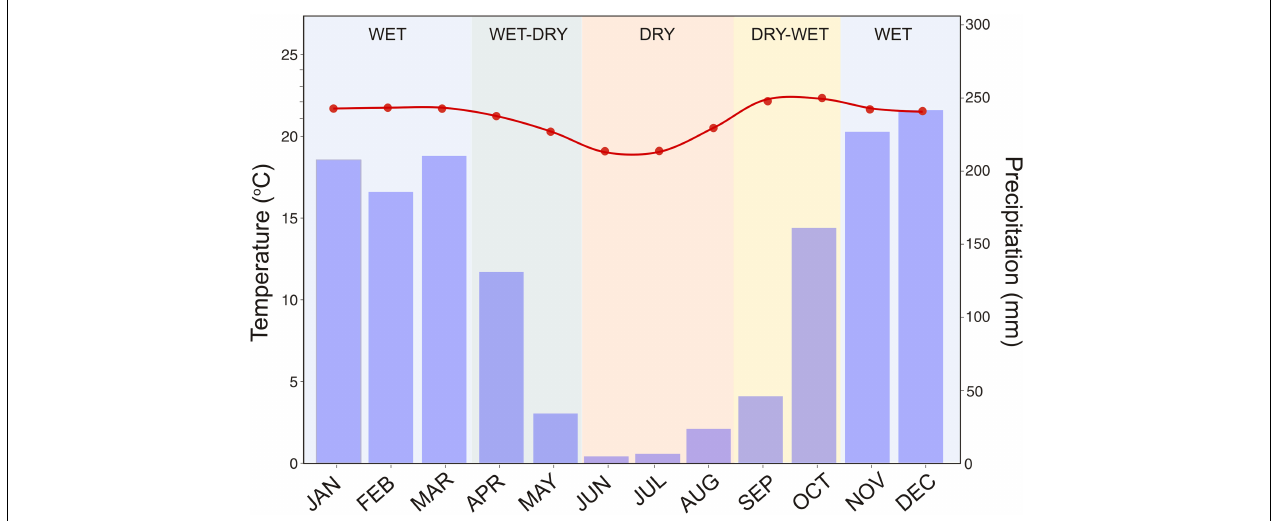
FIGURE 1 | Climatogram of the Brazilian Cerrado using records of precipitation (bars) and temperature (red points and lines) from 1981 to 2010. Data from National Institute of Meteorology (1981–2010) (INMET) for Brasilia station.